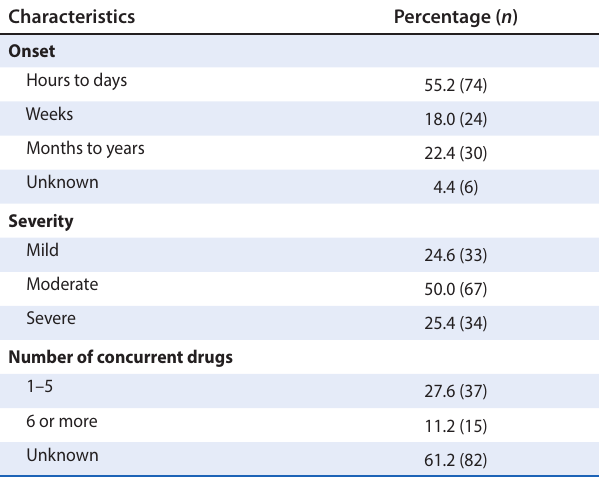
Table 2: ACDR onset, severity and number of concurrent drugs consumed Characteristics